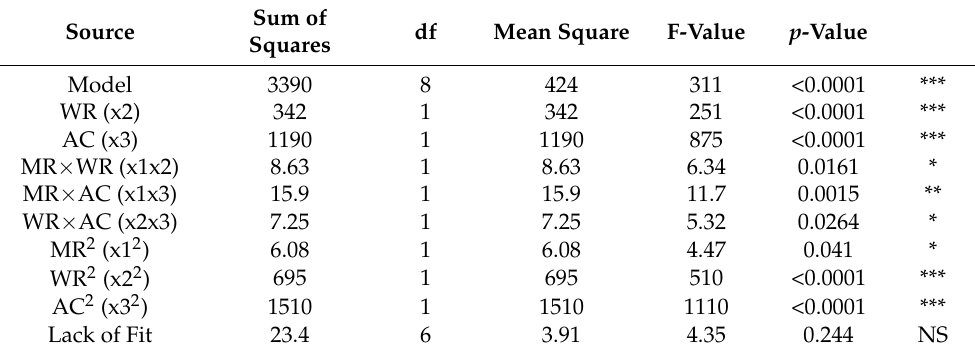
Table 3. ANOVA for response surface quadratic